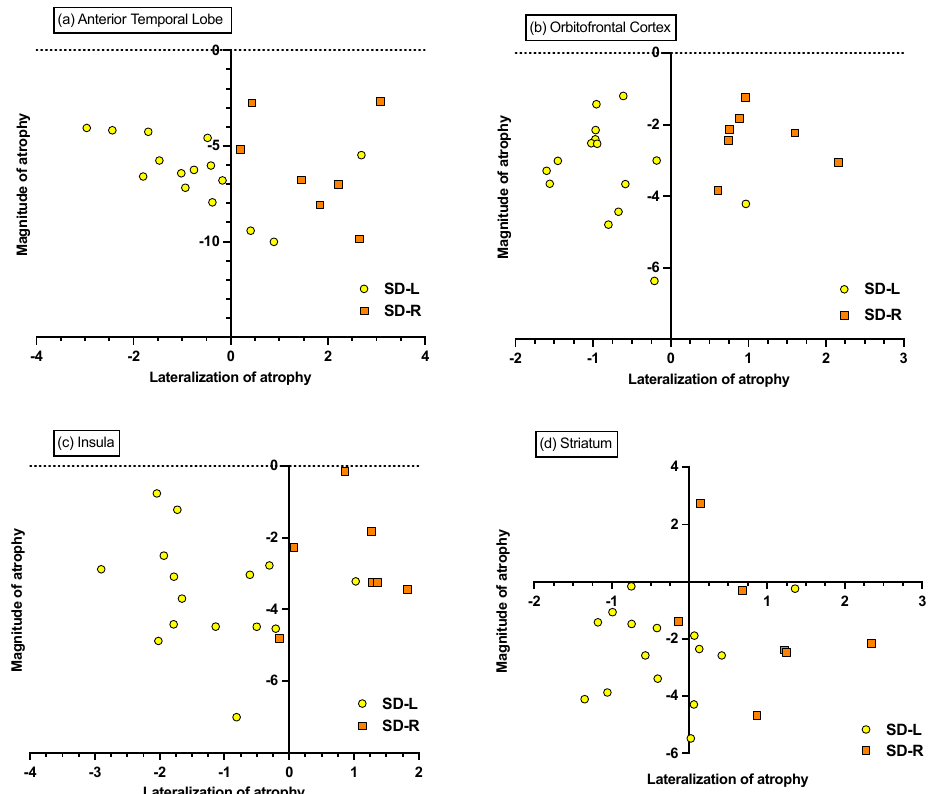
Figure 4. Magnitude and asymmetry of grey matter atrophy of ( a ) anterior temporal lobe, ( b ) orbitofrontal cortex, ( c ) insula, and ( d ) striatum in SD. All points indicate z -scored mean intensity values ( z -scored relative to the Control group). The magnitude of atrophy index (i.e., sum of left and right intensity values) indicates the total amount of atrophy relative to Controls, with lower scores indicating greater total bilateral atrophy. The asymmetry of the atrophy index (i.e., difference of left and right intensity values) captures the lateralisation of atrophy, with positive scores suggesting right-lateralised atrophy, negative scores suggesting left-lateralised atrophy, and scores at/around zero indicating bilateral atrophy of relatively equal